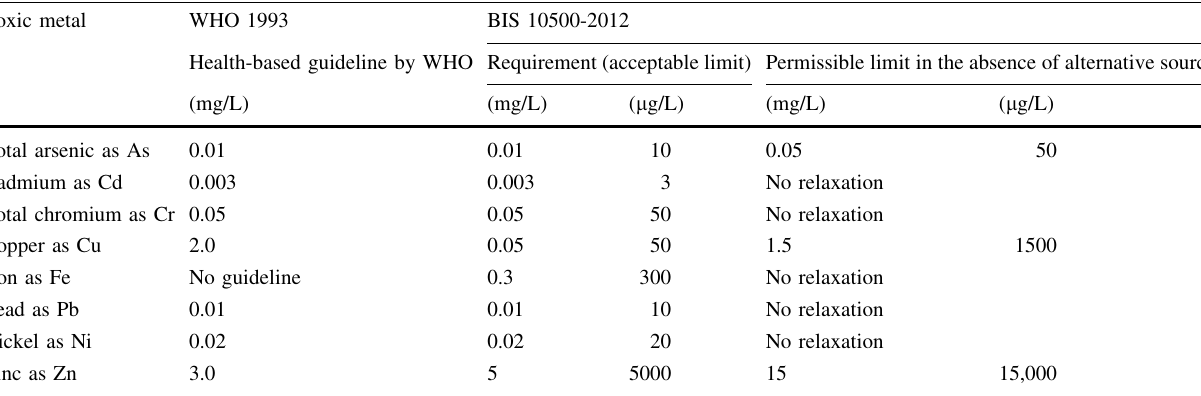
Table 1 Drinking water standards for trace and toxic metals (BIS-10500-2012) Toxic